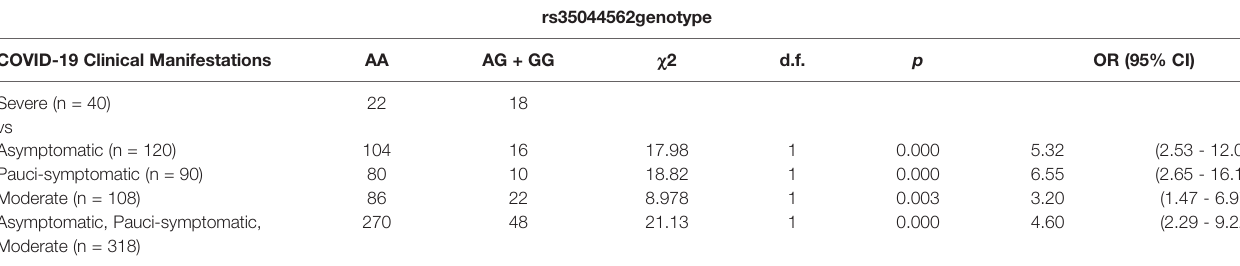
TABLE 3 | Association of severe COVID-19 with LZTFL1 polymorphisms in an allele